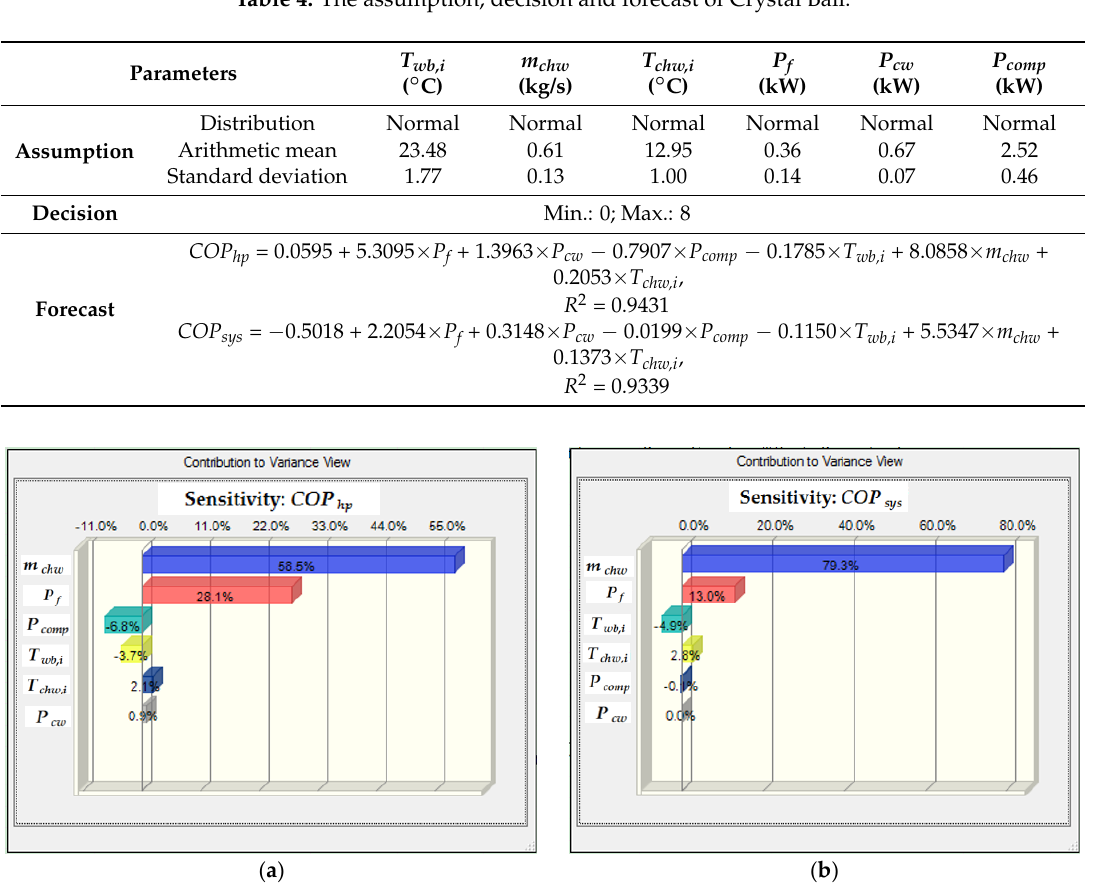
Figure 7. Sensitivity analysis on the values of ( a ) COP hp and ( b ) COP sys .